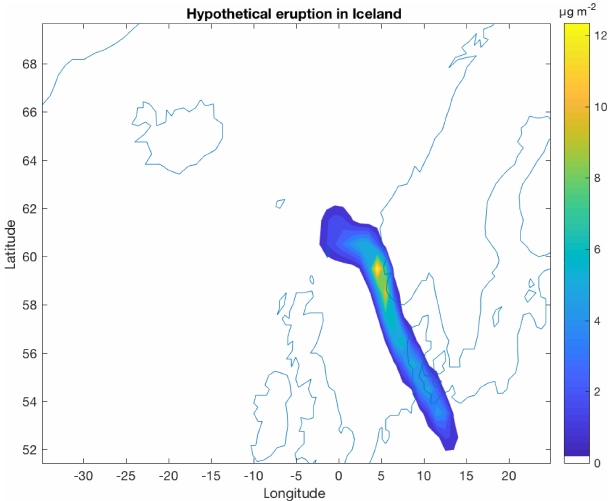
Figure 9. Hypothetical Grímsvötn eruption on 1 April 2015